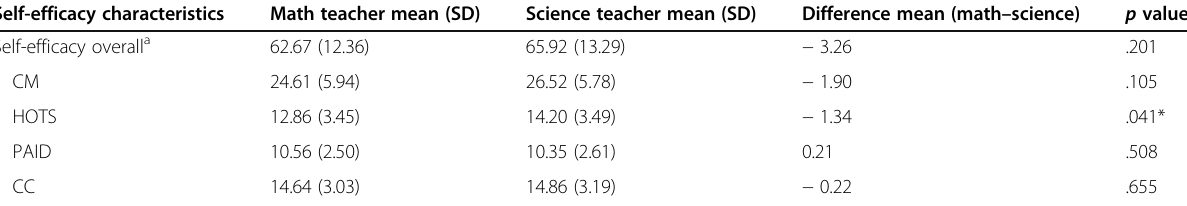
Table 6 Differences in science and math teacher self-efficacy characteristics by the mean Self-efficacy